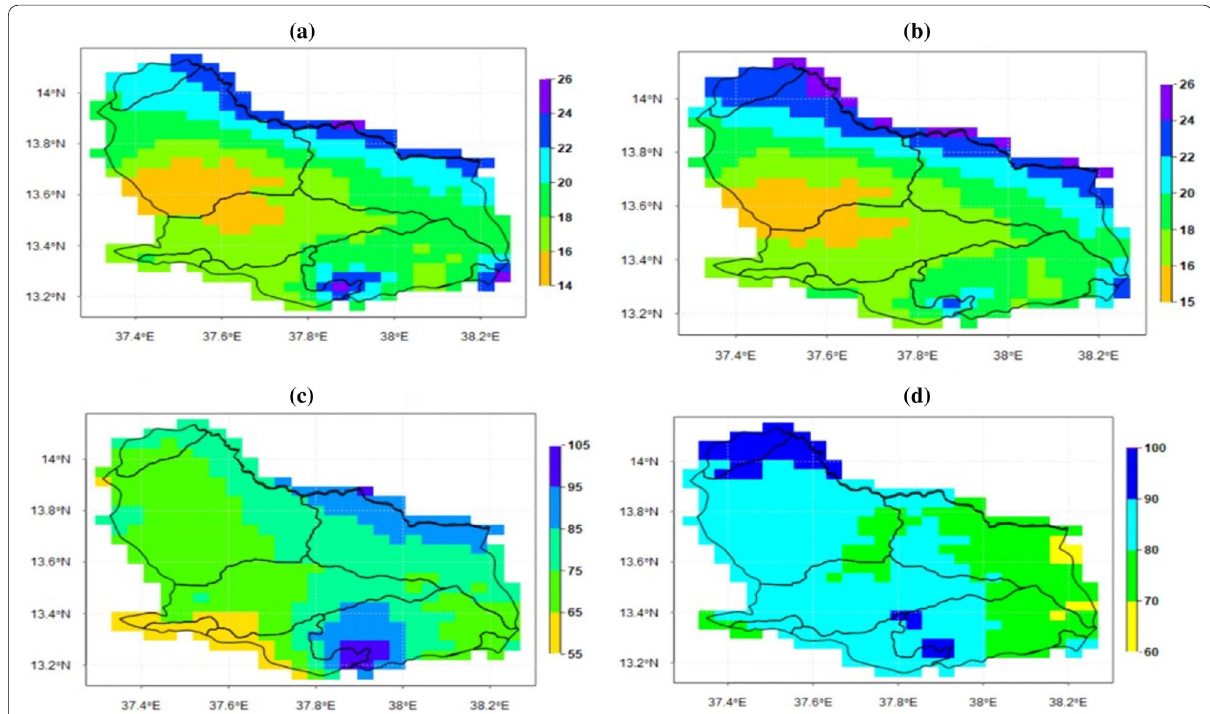
Fig. 7 Coefficient of variation of the annual ( a ) and Kiremit season ( b ), Belg season ( c ) and Bega